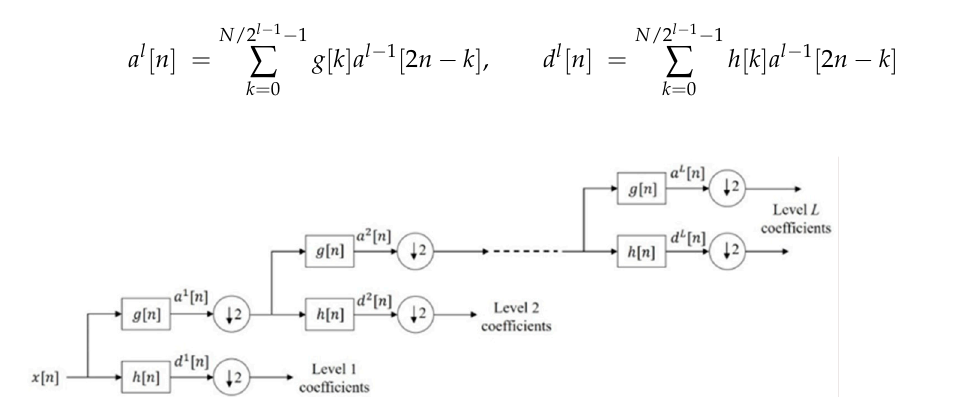
Figure 4. Decomposition process for the discrete signal in